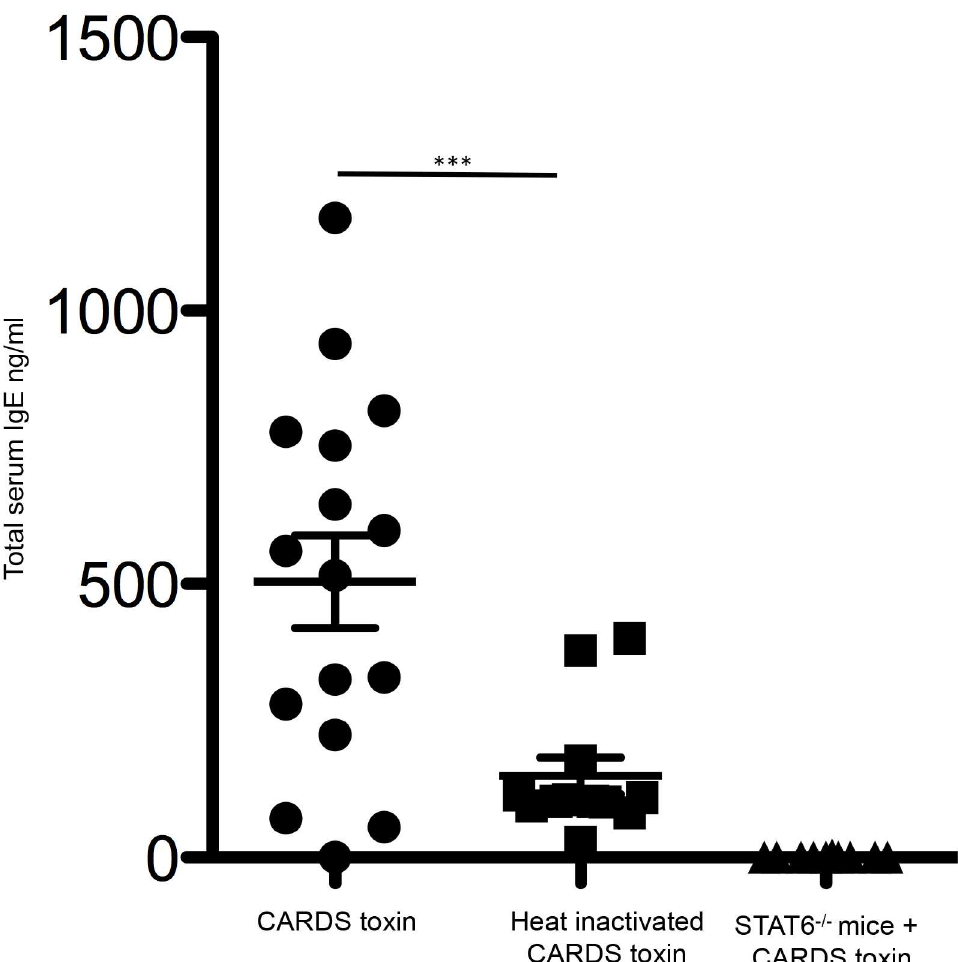
Fig 2. CARDStoxin activity and STAT6 are required for increased total serum IgE following CARDS toxin exposure. Balb/cJ mice or STAT6-/- mice were treated with active CARDS toxin or heat-inactivated CARDS toxin IT and then serum was collectedafter 56-days. Concentrations of total serum IgE is presented as the mean and standarddeviationof two independent experiments. Each symbol representsa mouse N = 16 mice ( *** p < 0.0005 note that the STAT6-/- could not be evaluatedstatistically due to 15/16 values being